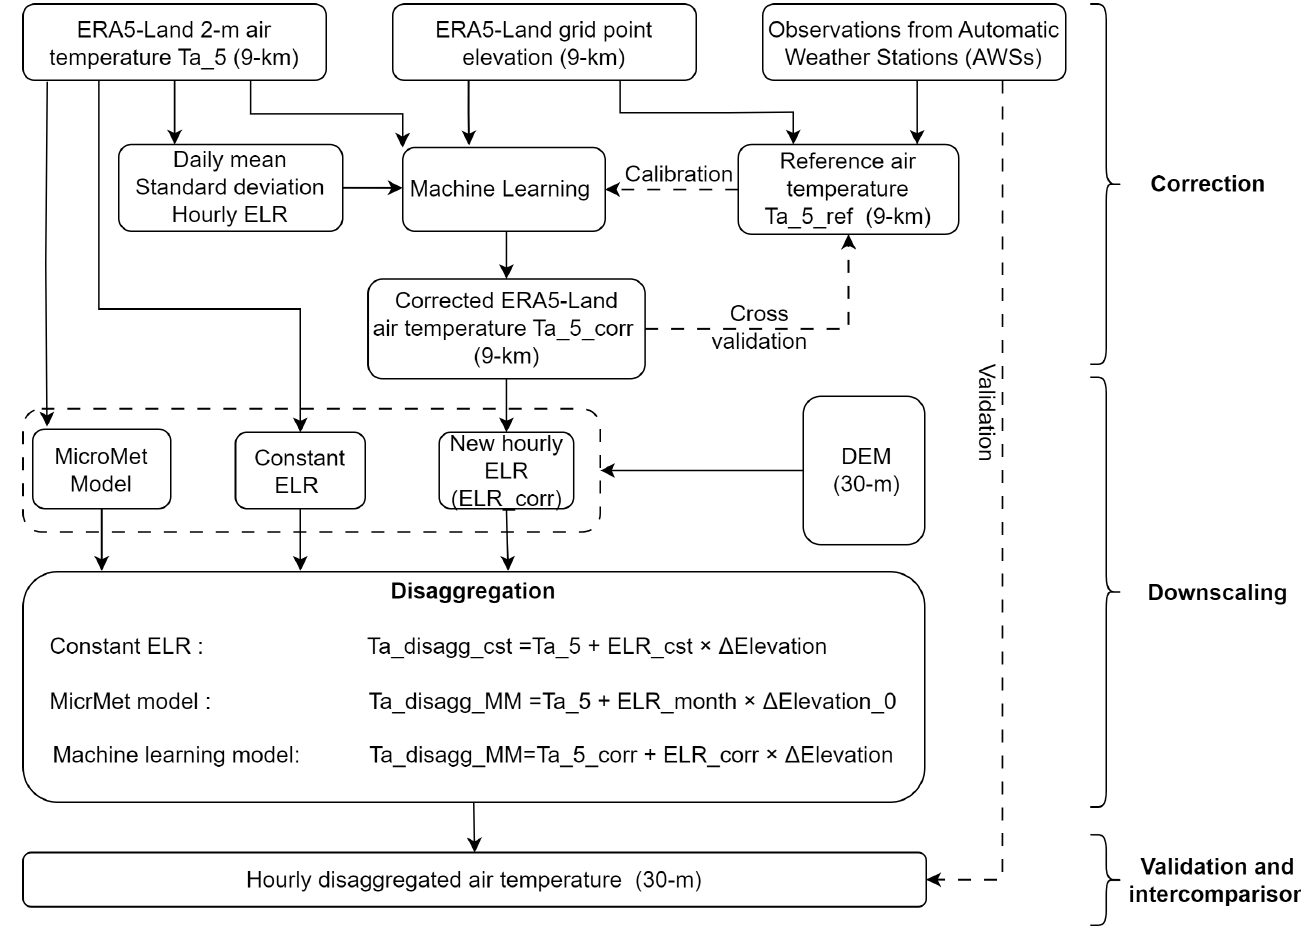
Figure 4. Flowchart of the methodological